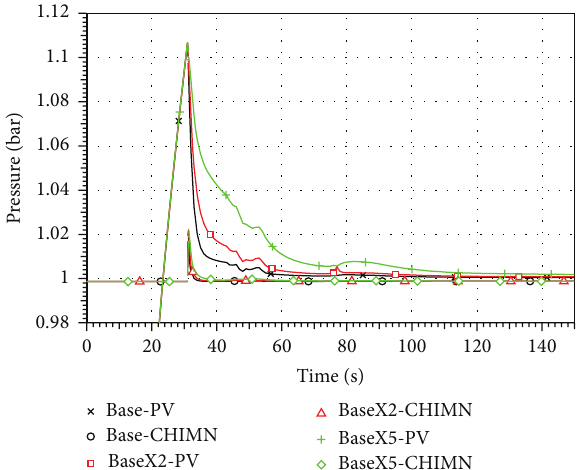
Figure 17: Pressure losses: comparison of pressure in PV and CHIMNEY.